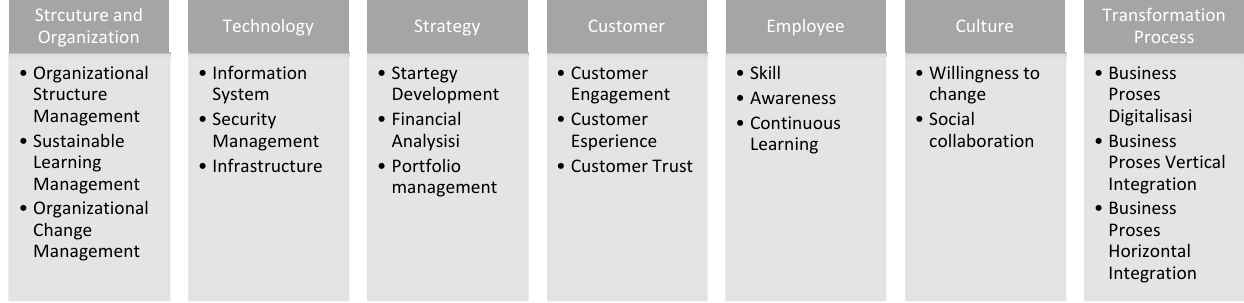
Figure 4. Dimensions and description of DX-SAMM.